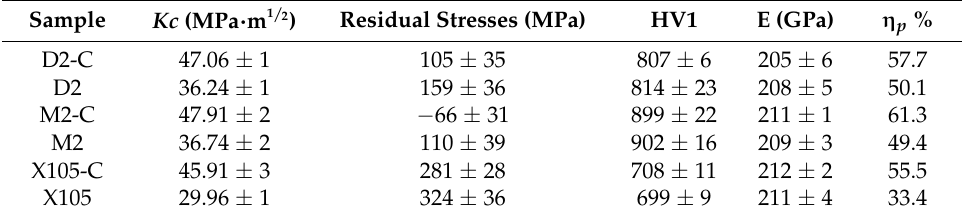
Table 4. Results of fracture toughness tests, residual stresses analysis, and Vickers hardness test.